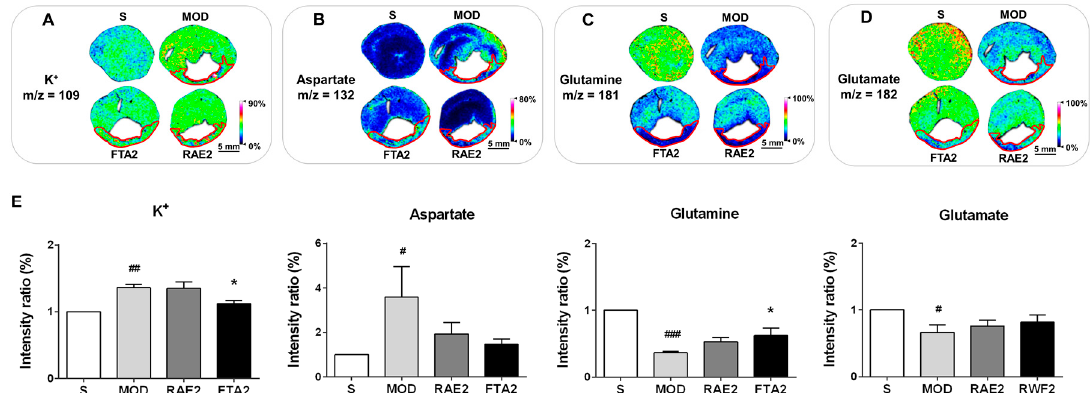
Figure 8. FTA changed potassium ion levels and glutamine. In situ MALDI–MSI of ( A ) potassium ions, ( B ) aspartate, ( C ) glutamine, and ( D ) glutamate. ( E ) Relative intensity ratios of these molecules were normalized and analyzed using SCiLS Lab. Spatial resolution = 200 µ m; scale bar = 5 mm. m/z: mass-to-charge ratio. S, sham surgery group; MOD, MI model group; RAE2, 0.8 g / kg Radix Aconiti Lateralis Preparata extract group; FTA2, 0.8 g / kg fuzi total alkaloid group. Data are presented as mean ± standard error of the mean; n = 3 per group. # p < 0.05, ## p < 0.01, ### p < 0.001 vs. S group, * p < 0.05 vs. MOD group.